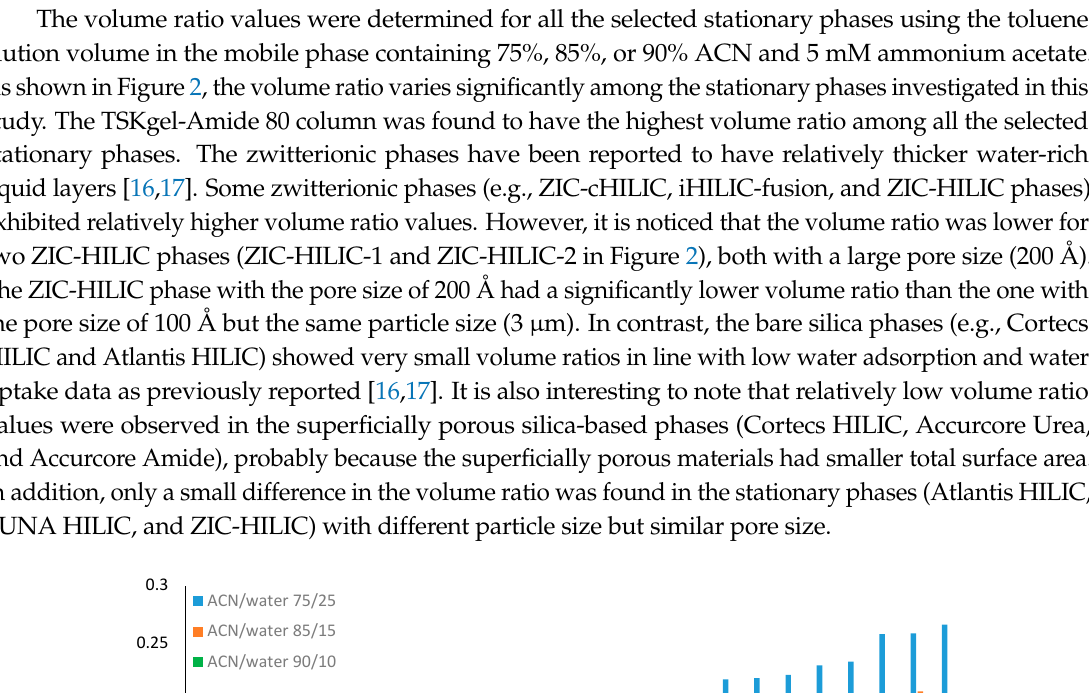
Figure 1. Correlation of the volume ratio based on the toluene elution time and the phase ratio based on the water uptake data. Columns labels: 1: Atlantis hydrophilic interaction chromatography (HILIC) column (5 µm, 96 Å, 250 mm); 2: ZIC-HILIC (3.5 µm, 200 Å, 150 mm); 3: Hydroxyethyl A column (5 µm, 100 Å, 200 mm); 4: TSKgel Amide-80 column (3.5 µm, 100 Å, 100 mm); and 5: ZIC-cHILIC column (3 µm, 100 Å, 150 mm).